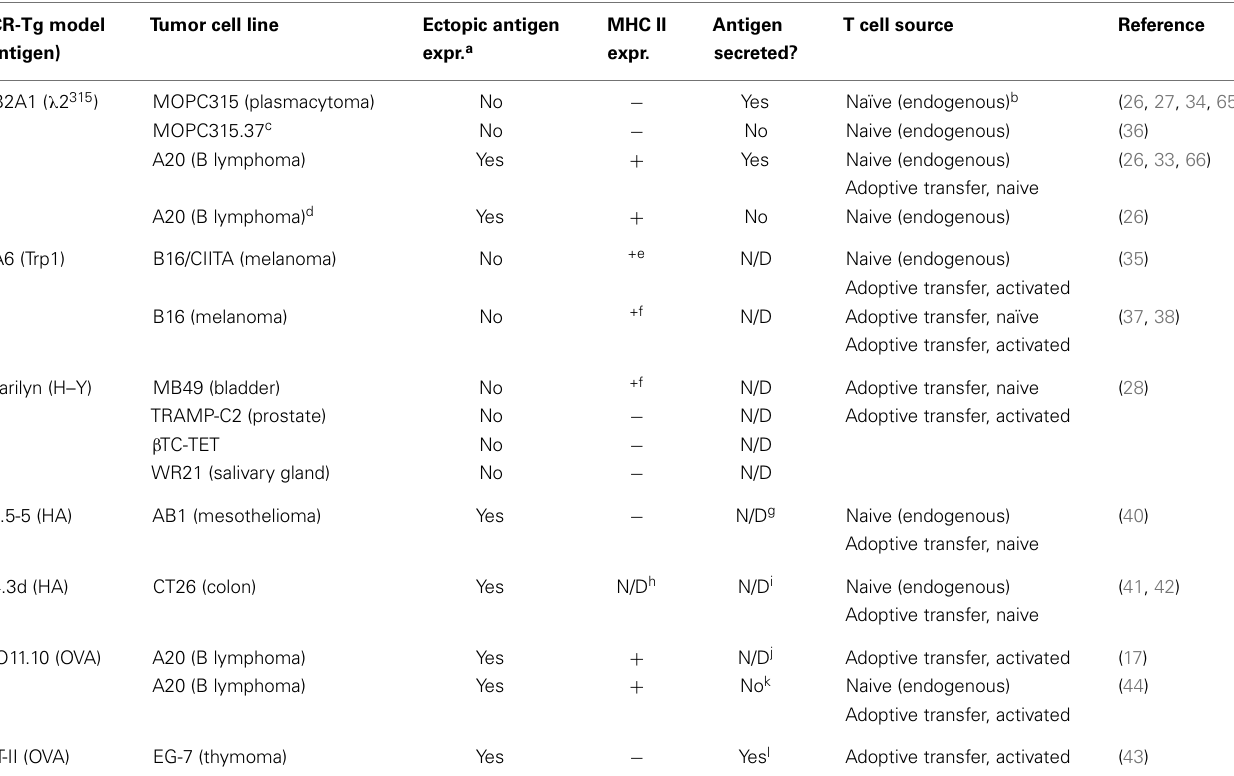
Table 2 | Use ofTCR-Tg models for studies of anti-tumor CD4 + T cell immune responses. TCR-Tg